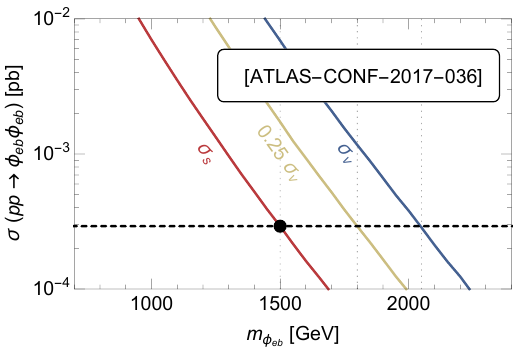
Figure 12 . Diagrams for pp ! S Final states and kinematic distributions of the two processes are identical.